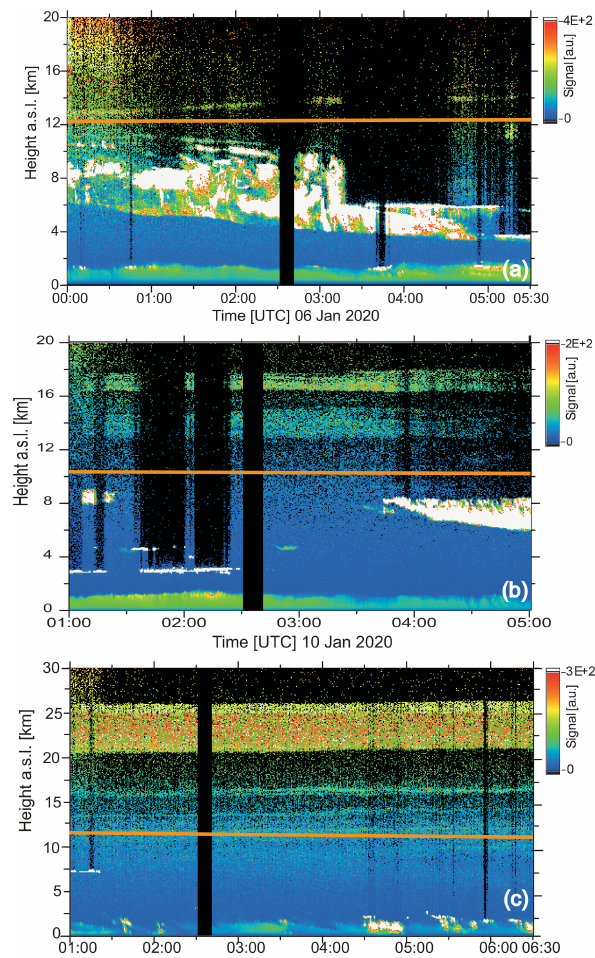
Figure 1. (a) Australian bushfire smoke in the troposphere, where the smoke layer extended from 6 to 11km at 00:00UTC and slowly descended with time, and in the stratosphere (a thin layer at 12.5km in the beginning and at 14km at the end on 6 January 2020). (b) Bushfire smoke in two layers from 13 to 15km and from 16 to 18km height on 10 January 2020. (c) Thin layers at 13 and 16km and a dense bushfire smoke layer from 20 to 26km height on 29 Jan- uary 2020. The smoke was observed with the lidar in Punta Arenas, Chile, 10000km downwind of the Australian fire areas. The range corrected 1064nm signal is shown. The tropopause heights accord- ing to the Punta Arenas radiosonde (launched at 12:00UTC, 08:00 local time) are given as orange horizontal lines. Black, column-like filaments above cloud layers (shown as white areas) indicate strong laser pulse attenuation. The large, well-defined black columns (from surface to 20km) indicate periods of automated depolarization cal- ibration. The complex white areas in (a) above 4km height indicate ice and mixed-phase clouds which caused ice virga formation (red and yellow). The clouds developed in smoke-containing air (green to blue with a few long-lasting coherent shallow smoke layers in yellow below and above the tropopause). These rather complex cloud features may be related to the occurrence of enhanced levels of smoke INPs (ice-nucleating particles) in the usually very pristine free troposphere with a low amount of very inefficient marine INPs (Kanitz et al.,